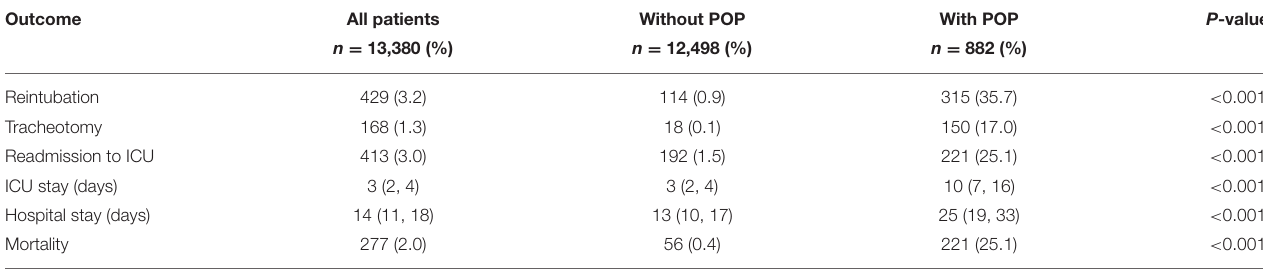
TABLE 6 | Postoperative variables in patients with and without POP after elective cardiac